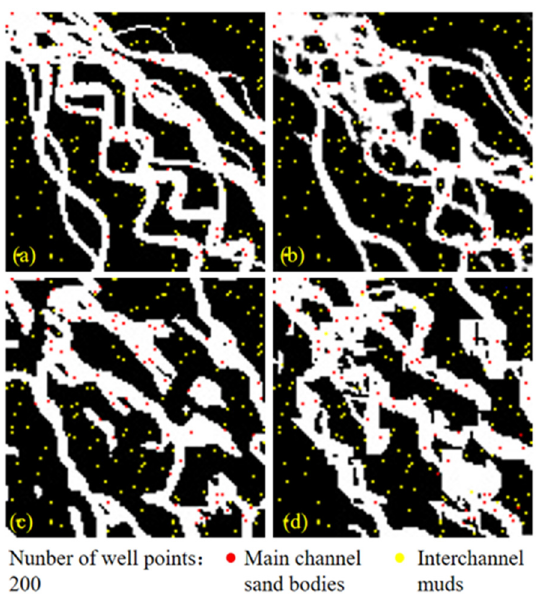
Figure 13. The comparison of the conditional modeling results between UCSC method and the traditional method. ( a ) Validation model; ( b ) model established by UCSC method; ( c ) model established by Snesim; ( d ) model established by Filtersim.